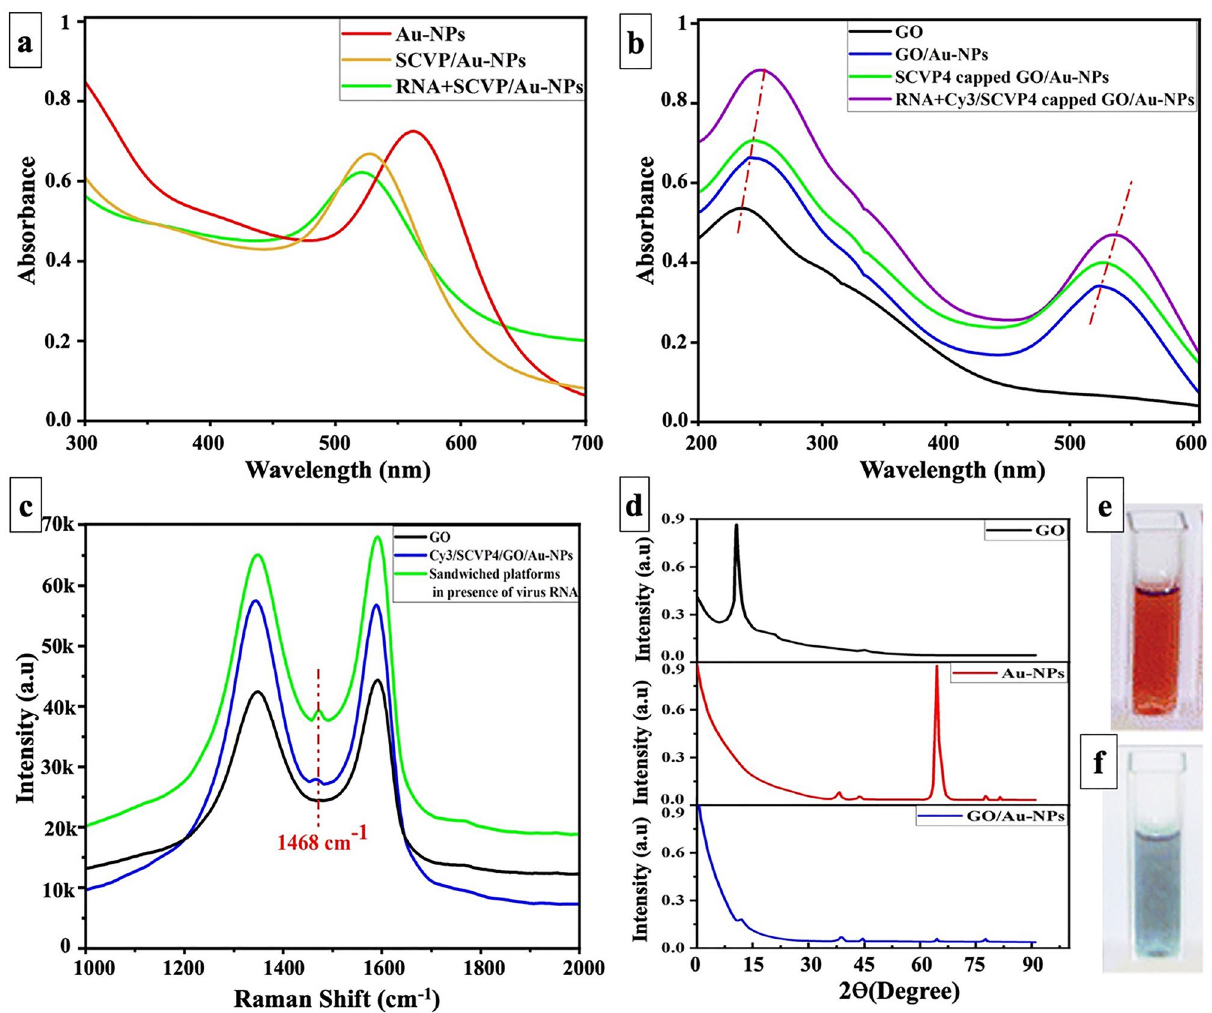
Figure 3. Characterization of synthesized nanoparticles and biosensor. ( a ) AuNPs, SCVPs capped AuNPs, virus RNA/SCVPs capped AuNPs UV–Vis absorption, ( b ) GO, GO/AuNPs, SCVP4 capped GO/AuNPs, virus RNA/SCVP4 capped GO/AuNPs UV–Vis absorption, ( c ) Raman spectroscopy of GO, Cy3/SCVP4 capped GO/ AuNPs, sandwiched dual-platform in the presence of viral RNA, ( d ) XRD patterns of GO, AuNPs, and GO/ AuNPs, Biosensor ( e ) before, and ( f ) 10 min after incubation with the SARS-CoV-2 RNA at 37